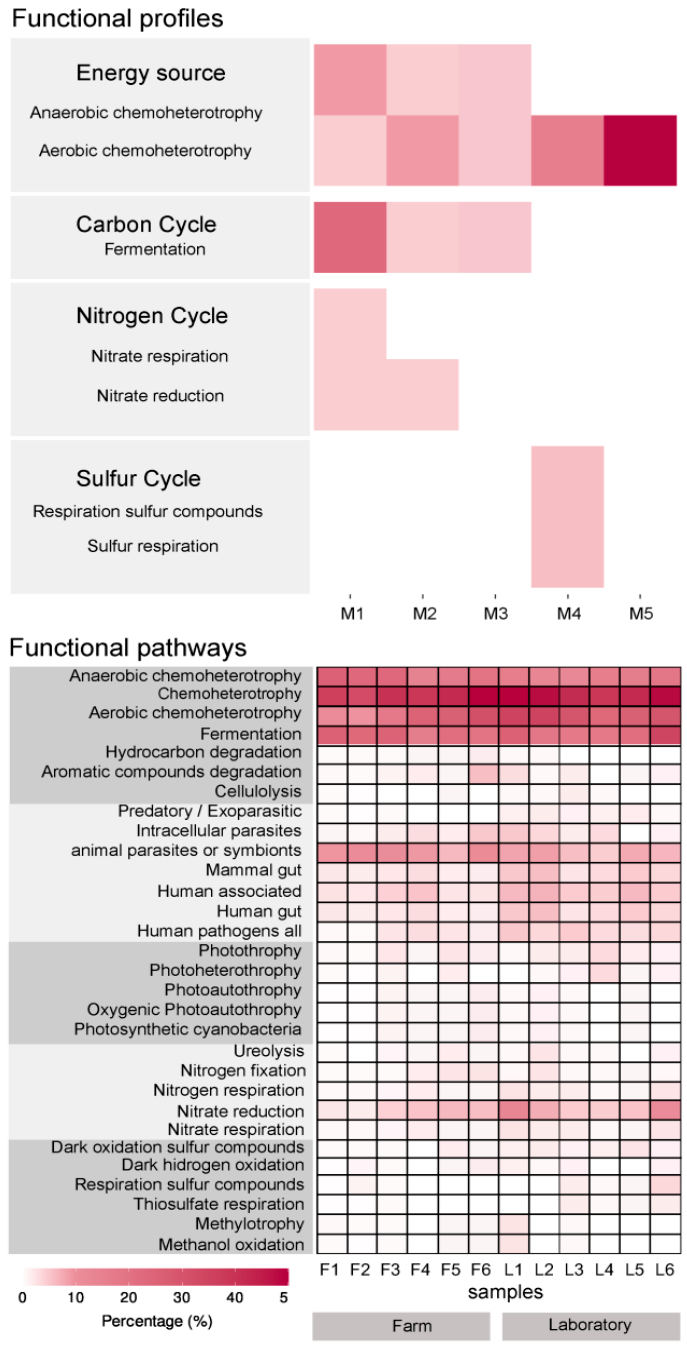
Figure 2. Predictive functional profiles based on 16S rRNA gene sequences from Argopecten purpu- ratus gills bacterial community ( n = 10 pooled individuals per sample). Five bacterial modules of co-occurrence were identified (M). Heatmap of the most abundant functional pathways obtained from FUNPROTAX analysis for gill microbiota between farm and laboratory-maintained scallops. Abun- dance percentage is represented in the color temperature bar.